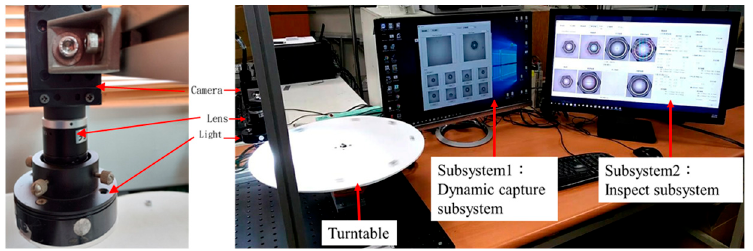
Figure 1. The inspection system is divided into three parts. Turntable simulation in the production line. Subsystem1 displays the status of dynamic capture. Subsystem2 displays the results of the geometric inspection.